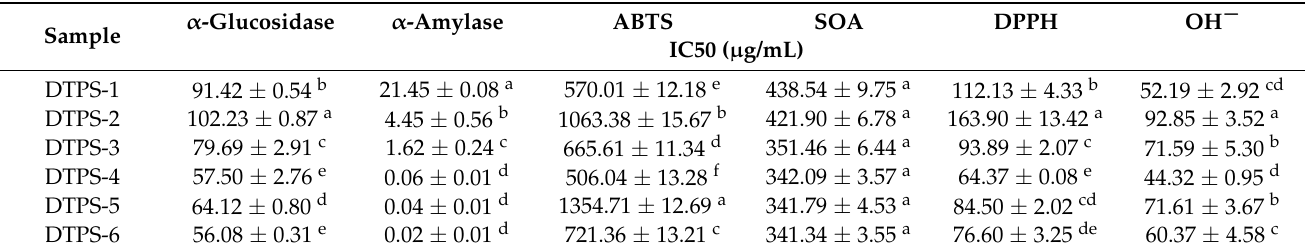
Table 4. Glycosidase inhibition and free radical scavenging activities (IC50) of the DTPSs.